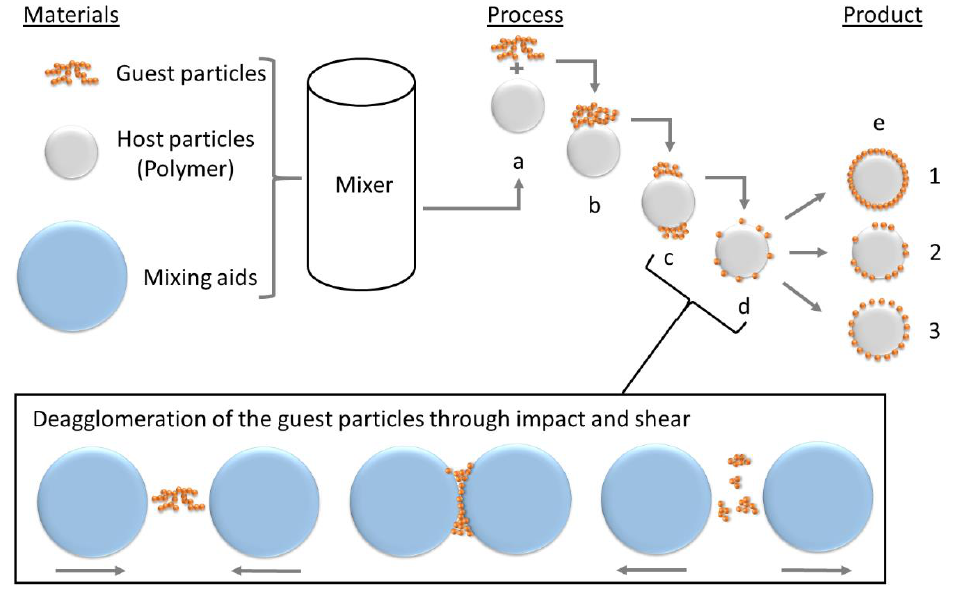
Figure 1. Process of dry coating, described by Alonso et al. [62 – 64]. ( a ) addition of GP to HP and first contact ( b ); ( c ) deagglomeration and ( d ) dispersion of the GP; ( e ) different product qualities to